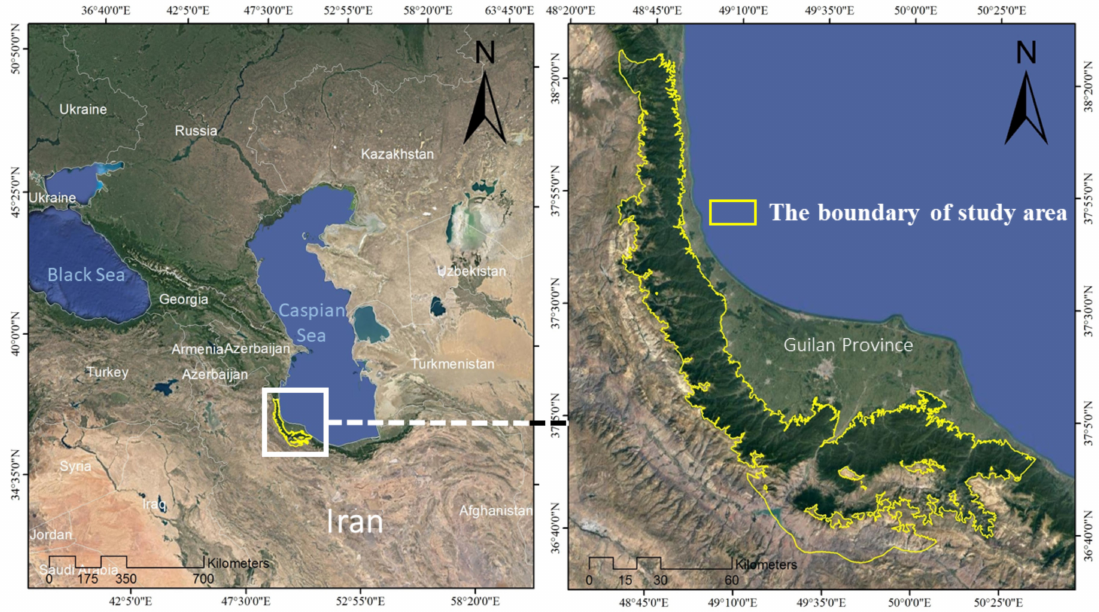
Figure 2. The geographic location of the selected area under study, Guilan Province, is represented in the user interface of Google Earth Engine